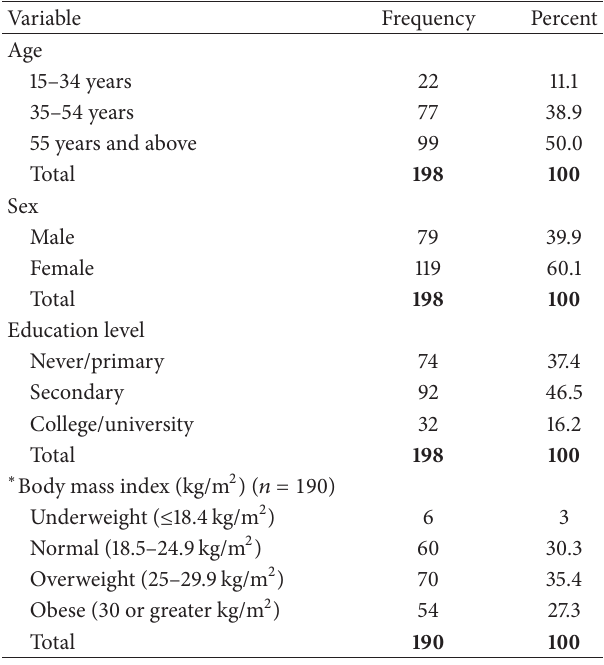
Table 1: Demographic characteristics of the patients ( 𝑛 = 198